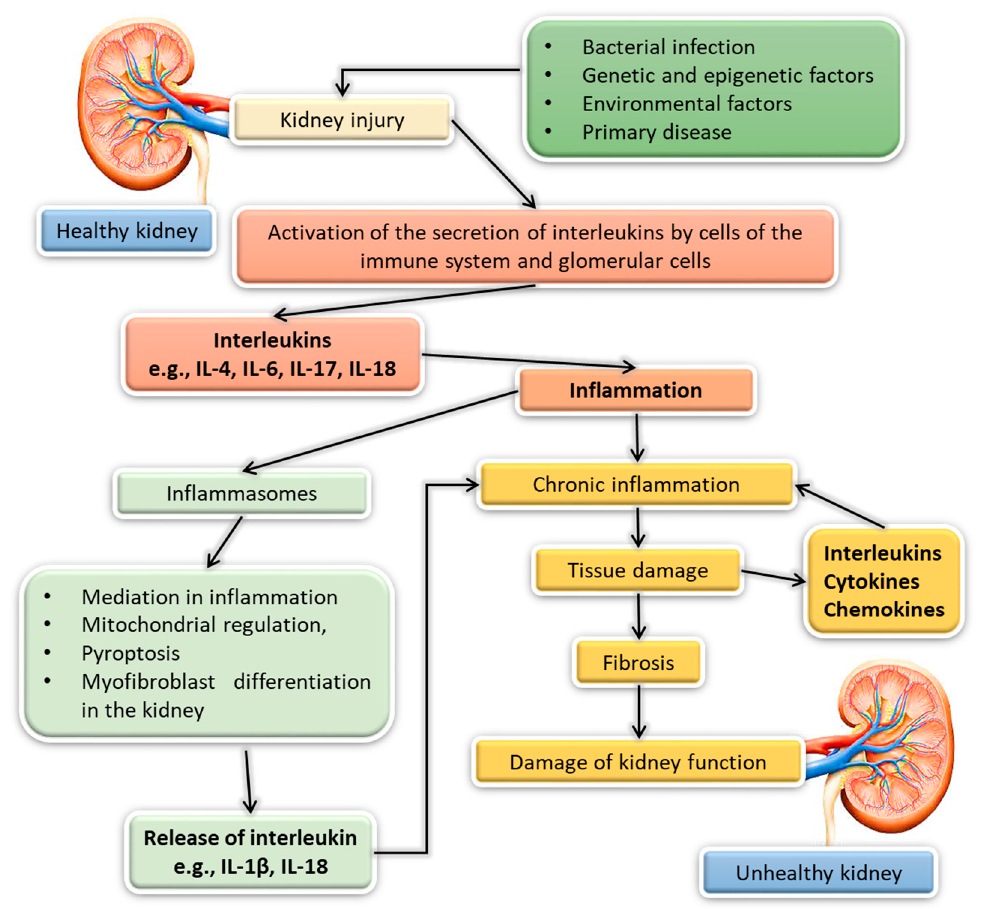
Figure 3. Influence of interleukins on the development of chronic inflammation and, consequently, kidney damage [173,178,188]. kidney damage